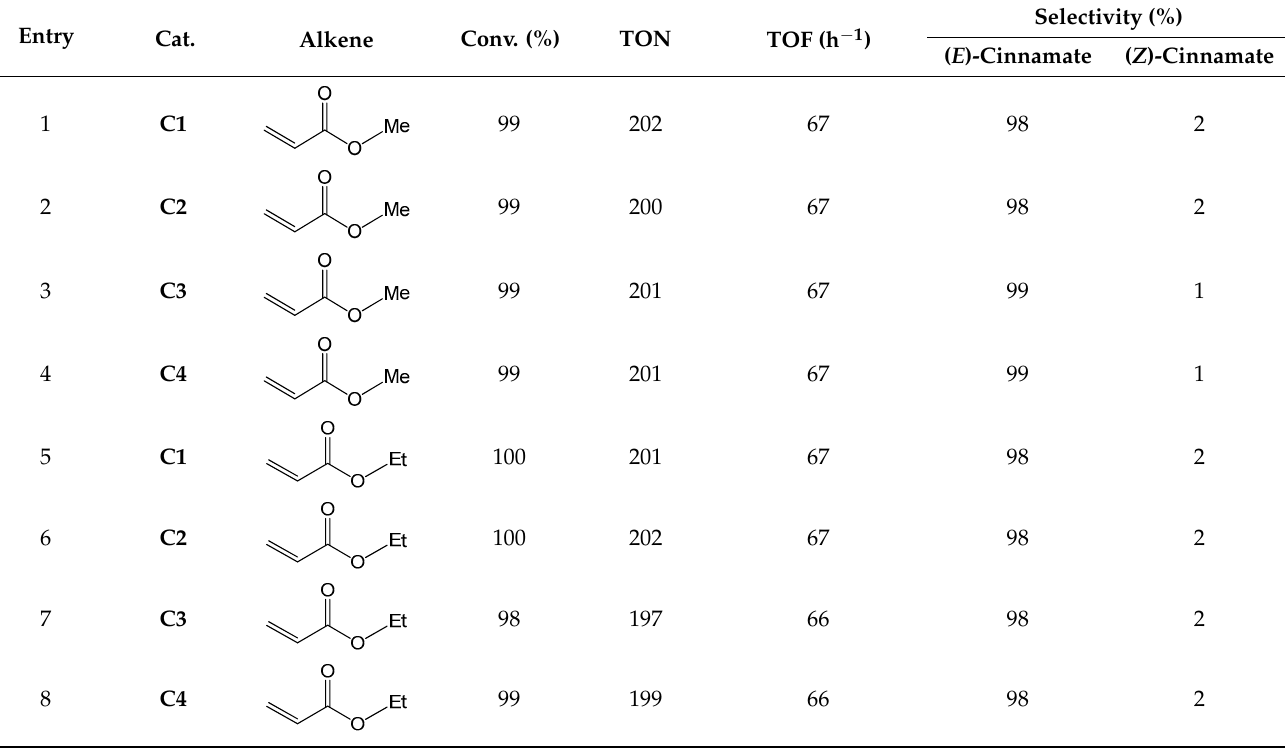
Notes: Reactions carried out in DMF (1.2 mL) with 0.66 mmol of iodobenzene, 0.726 mmol of methyl/ethyl acrylate, 1.32